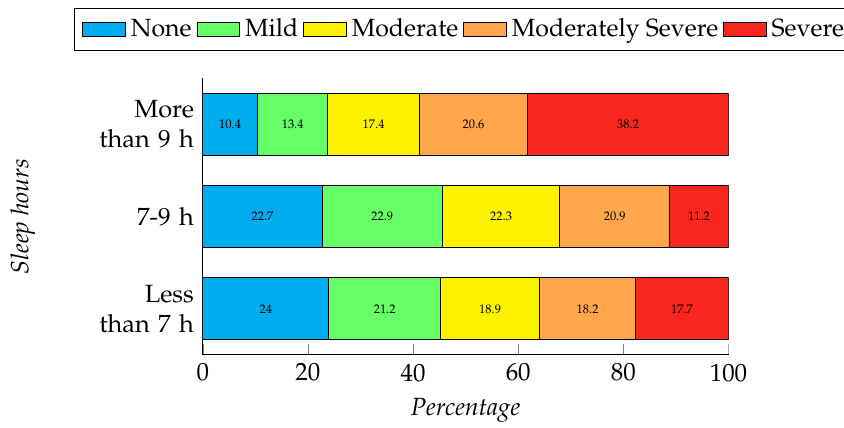
Figure 3. Relation between students’ sleep hours and their level of depression.